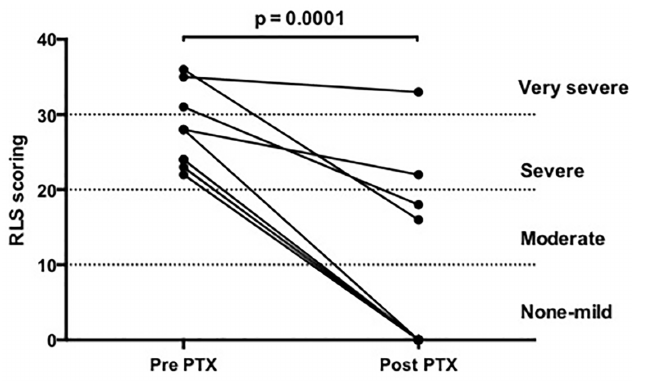
Fig 2. Scoring obtained with the international restless leg syndrome (RLS) severity scale questionnaire, pre- and post-parathyroidectomy.